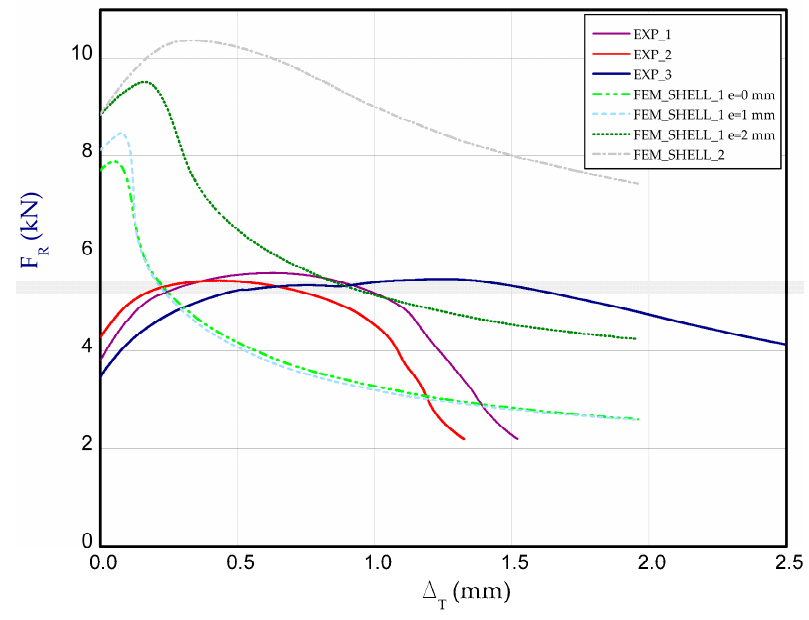
Figure 21. The compression curves of column at 200 °C.